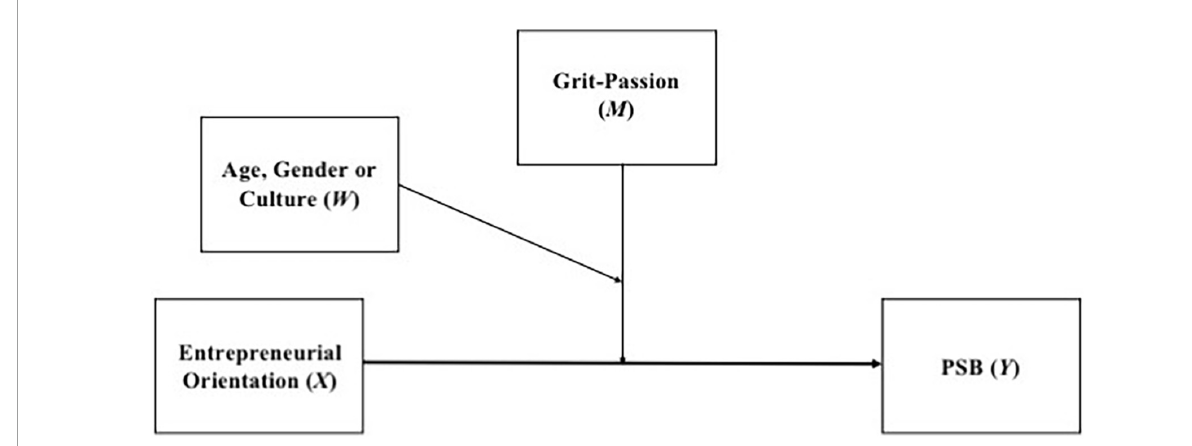
FIGURE2 Conceptual model of double moderation analysis.